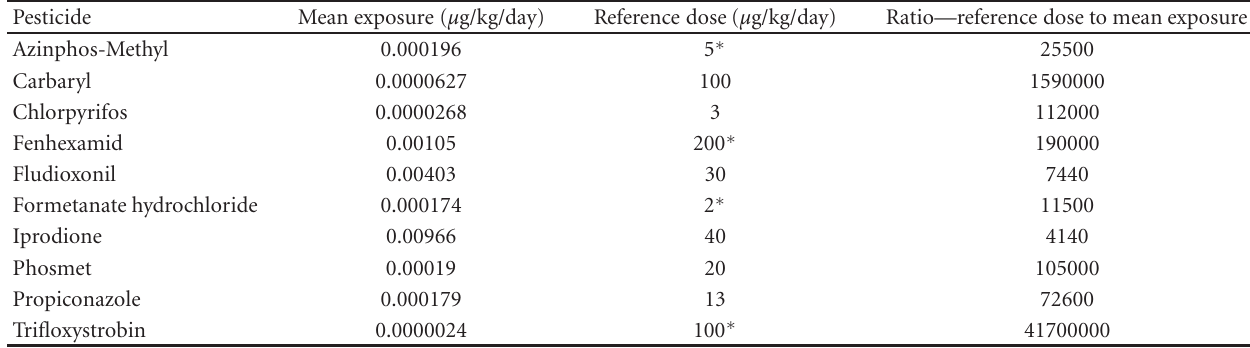
Table 9: Exposure estimates of the ten most frequently detected pesticides on nectarines.